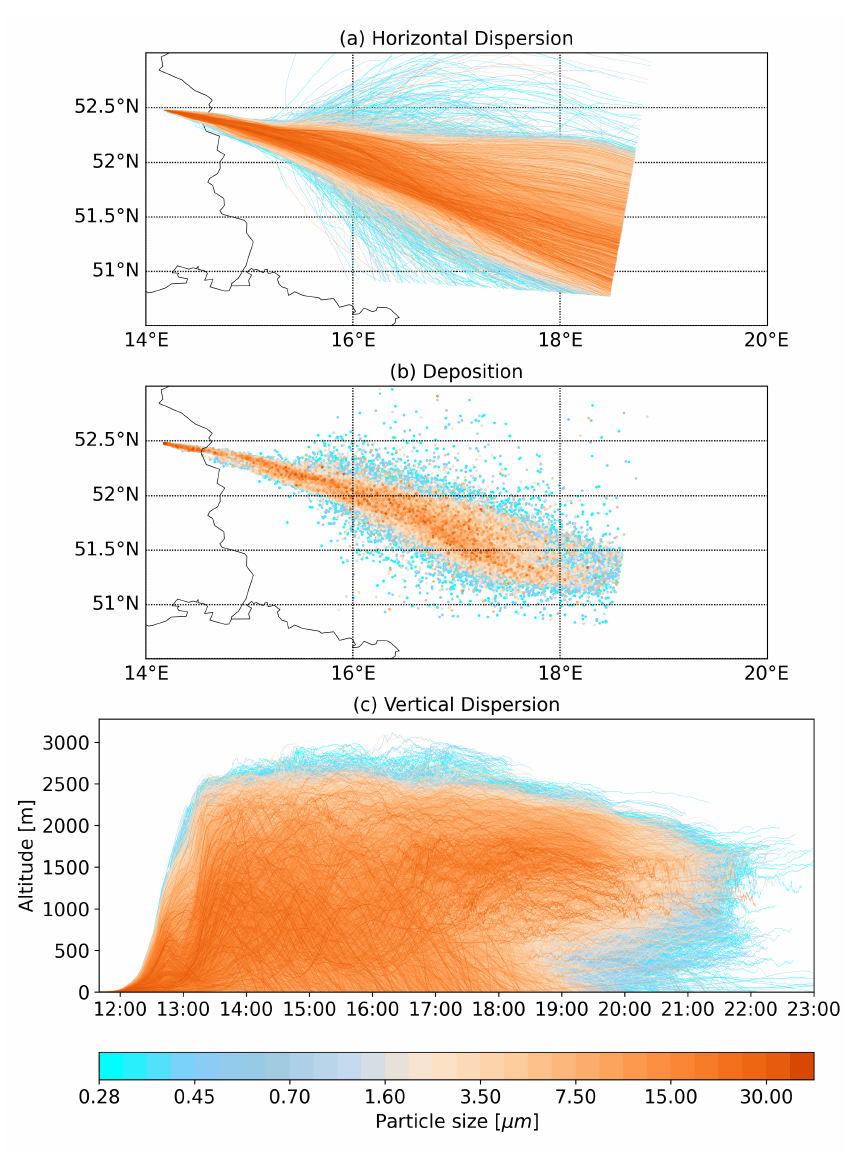
Figure 5. Particle motion of EXP2: (a) horizontal trajectories, (b) deposition points, (c) vertical trajectories.